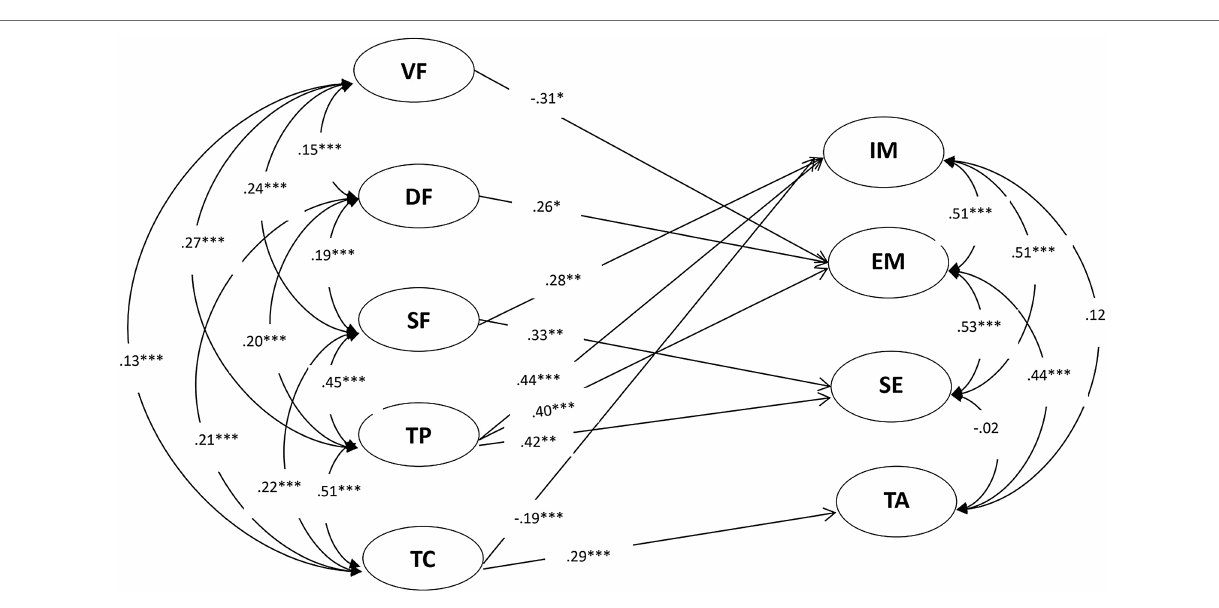
FIGURE 4 | Relationships between female students’ perceptions of teacher feedback and their motivation in language. * p < 0.05, ** p < 0.01 and *** p < 0.001. VF, verification feedback; DF, directive feedback; SF, scaffolding feedback; TP, teacher praise; TC, teacher criticism; IM, intrinsic motivation; EM, extrinsic motivation; SE, self-efficacy and TA, test